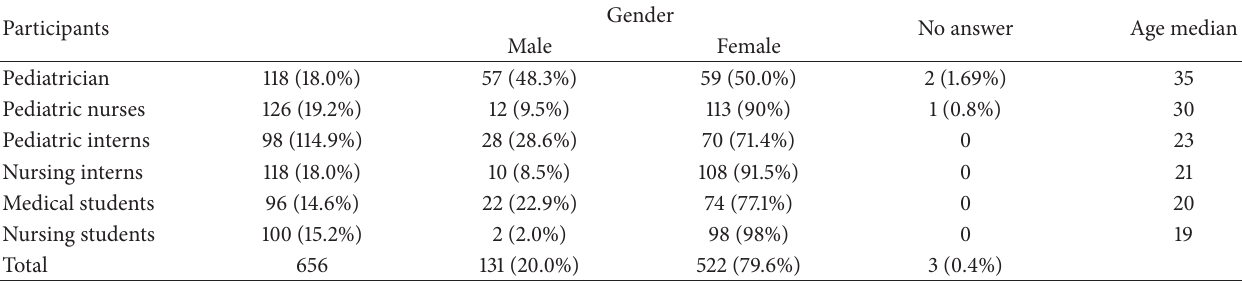
Table 1: Descriptive data stating gender and median age for responding participants.